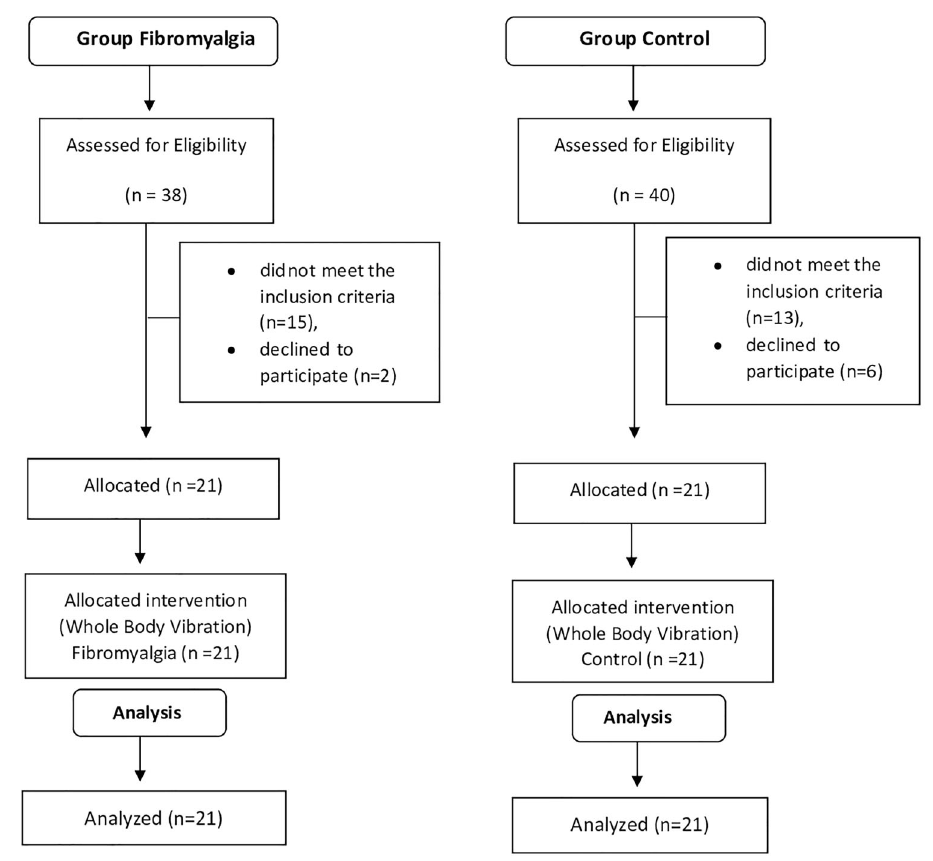
Figure 1. Flowchart of the